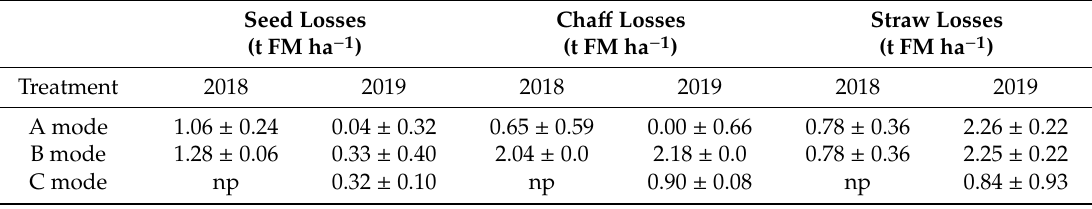
Table 9. Biomass losses as fresh matter (seed, cha ff , and straw) according to the di ff erent treatment modes, in 2018 and